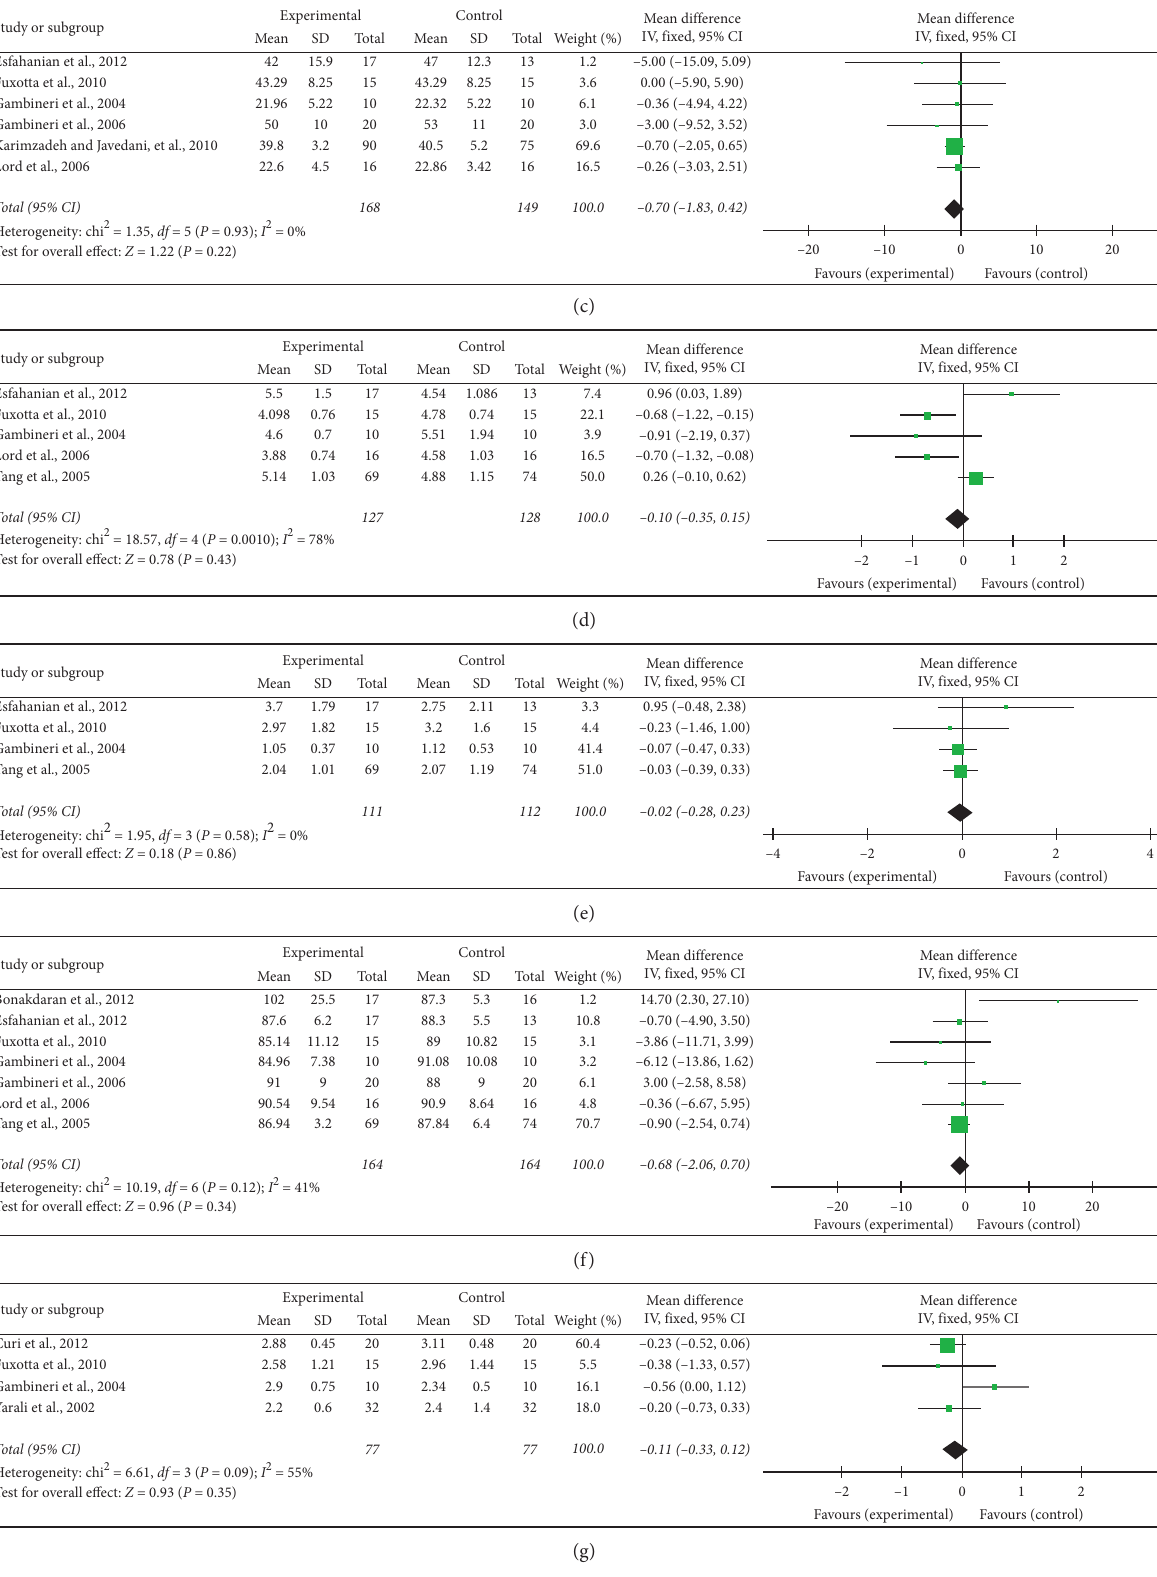
Figure 4: Effect of metformin on (a) homeostasis model assessment of insulin resistance; (b) sex hormone-binding globulin; (c) high- density lipoprotein; (d) total plasma cholesterol; (e) triglycerides; (f) fasting blood glucose; and (g)